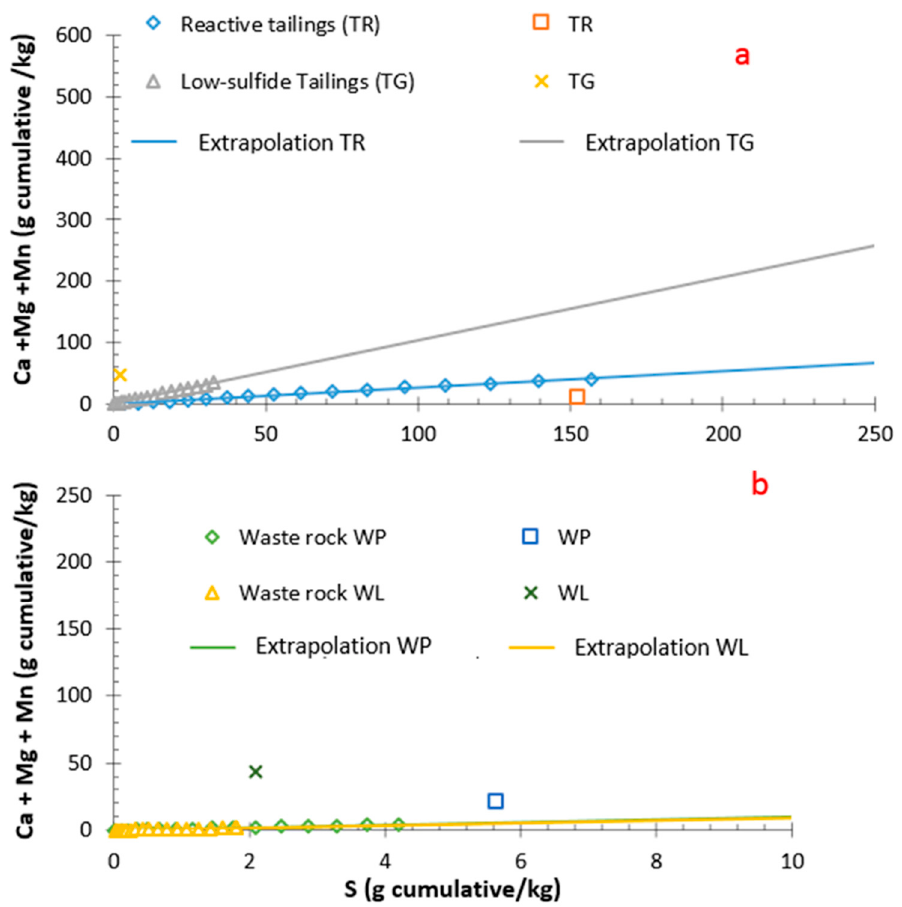
Figure 7. Oxidation–neutralization curves for the: ( a ) tailings and ( b ) waste rocks. Points represent the initial compositions of the materials.